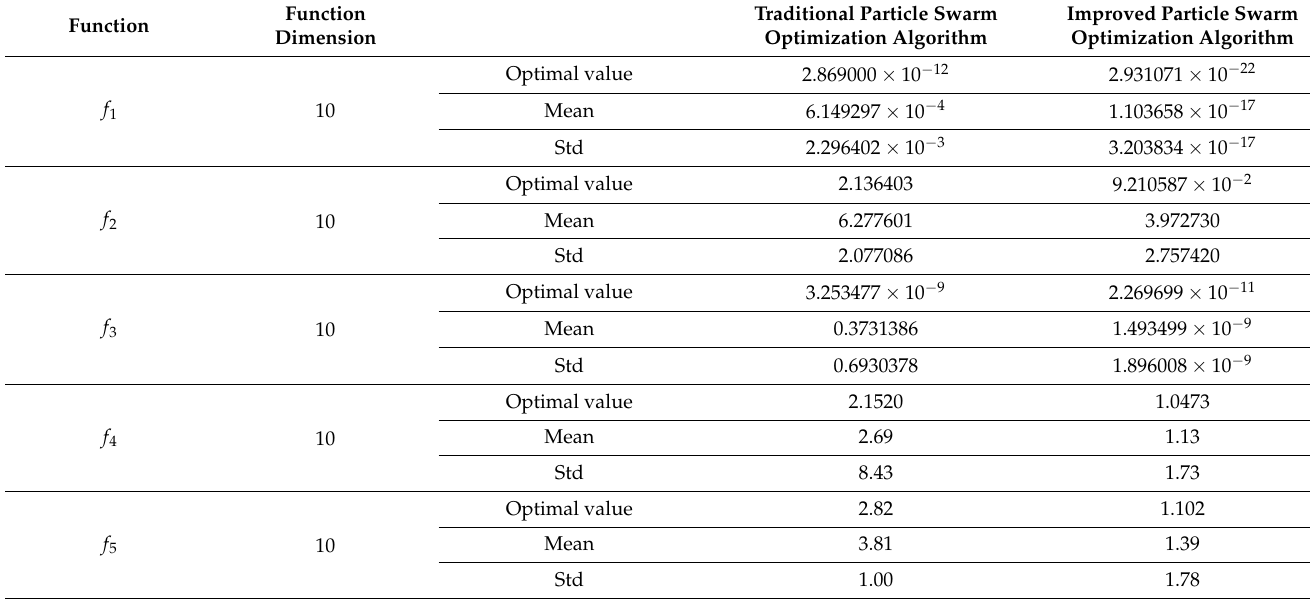
Table 2. Function optimization